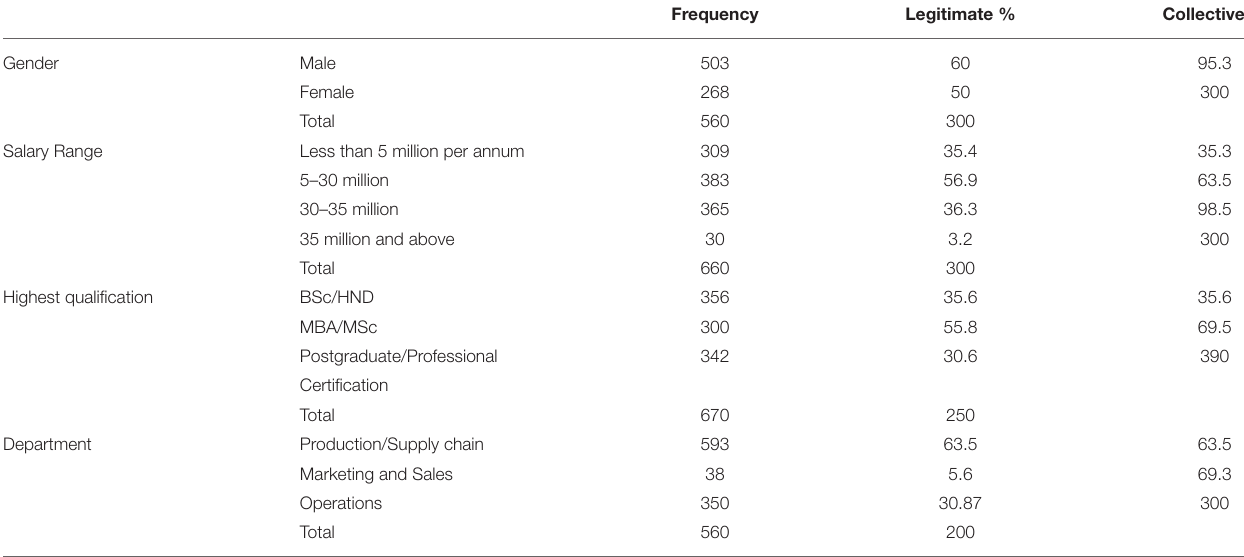
TABLE 1 | The respondent’s demographics.